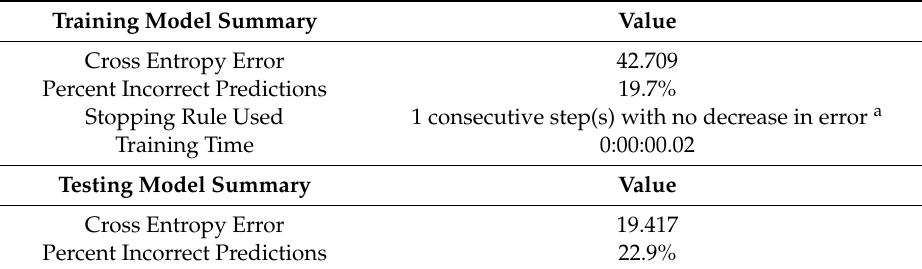
Figure 4. The architecture of the typical neural network utilized in the artificial neural network module. BMI, body mass index; CR, cardiac rehabilitation; HADS, hospital anxiety and depression scale; SF, Short Form; GH, general health; and PF, physical functioning. Table 5. Model summary of the artificial neural